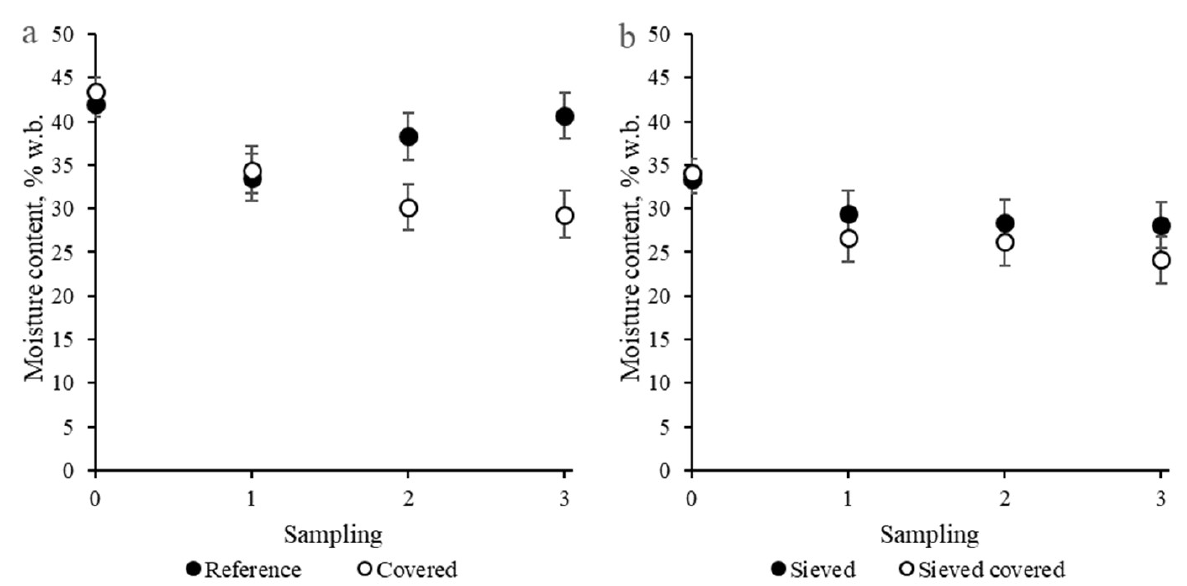
Figure 5. Mean moisture content (%, w.b.) and 95% level of confidence intervals of unsieved ( a ) and sieved ( b ) wood chips during storage.